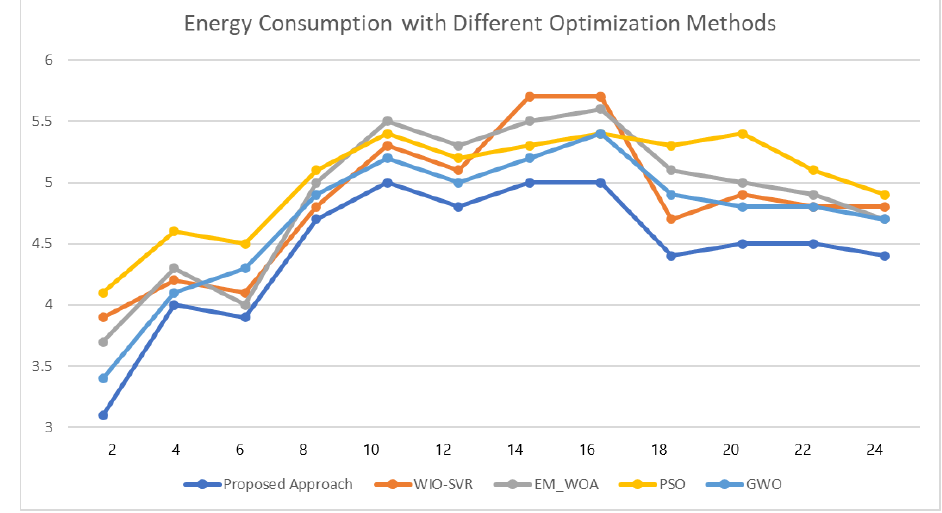
Figure 11. Results for energy consumption using different optimization